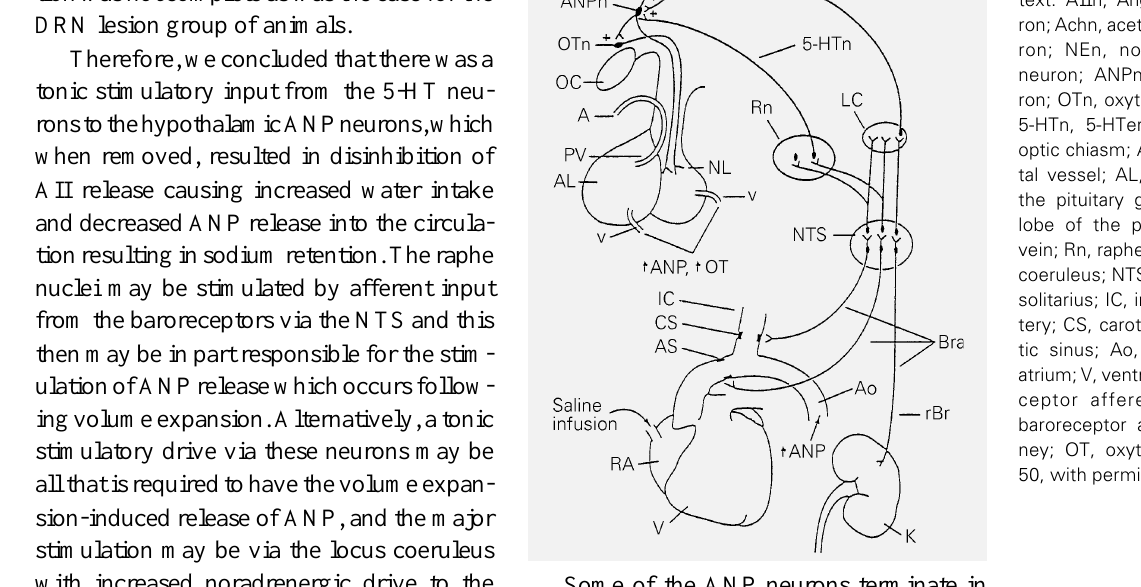
Figure 1 - Schematic diagram of the ANP neuronal control of ANP release. For explanation see the text. A II n, Angiotensin II neu- ron; Achn, acetylcholinergic neu- ron; NEn, norepinephrinergic neuron; ANPn, ANPergic neu- ron; OTn, oxytocinergic neuron; 5-HTn, 5-HTergic neuron; OC, optic chiasm; A, artery; PV, por- tal vessel; AL, anterior lobe of the pituitary gland; NL, neural lobe of the pituitary gland; v, vein; Rn, raphe nuclei; LC, locus coeruleus; NTS, nucleus tractus solitarius; IC, internal carotid ar- tery; CS, carotid sinus; AS, aor- tic sinus; Ao, aorta; RA, right atrium; V, ventricles; Bra, barore- ceptor afferents; rBr, renal baroreceptor afferents; K, kid- ney; OT, oxytocin. (From Ref. 50, with